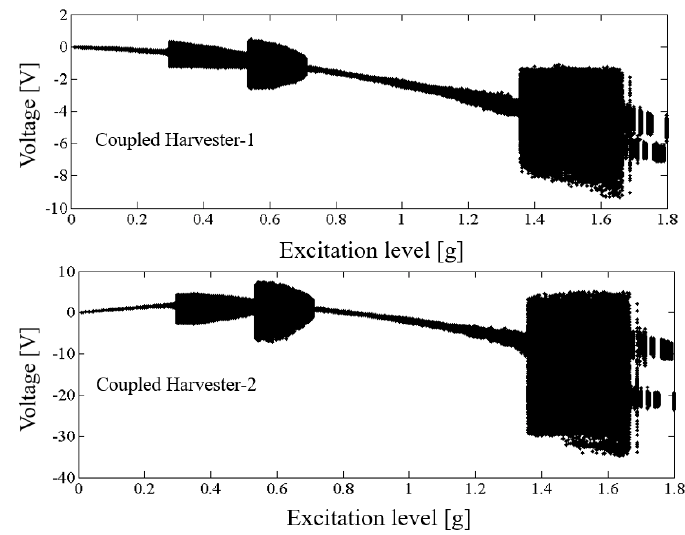
Figure 13. Bifurcation diagram of response voltages versus excitation levels. Sensors 2018 , 18 , x FOR PEER REVIEW